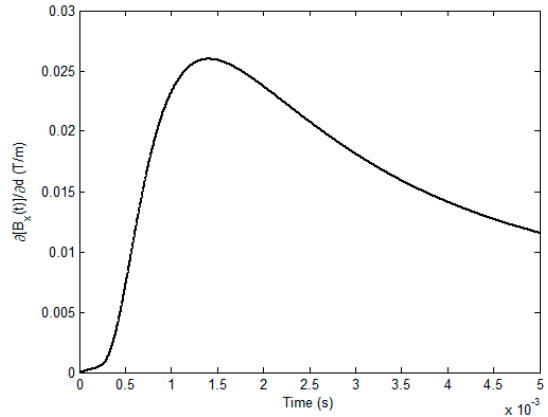
Figure 4. The computed response of B x to the initial subsurface corrosion (0 ≤ t ≤ 5 ms).